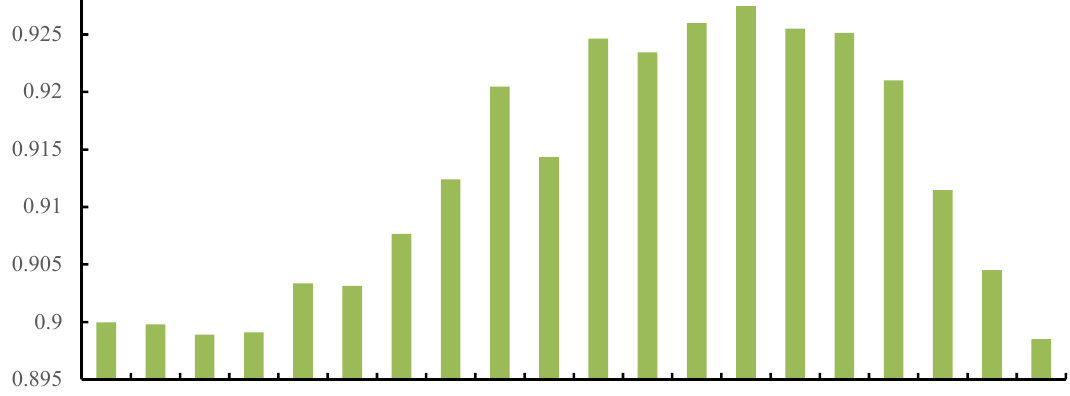
Figure 6. Degree of coordination between population and economy from 2000 to 2019.